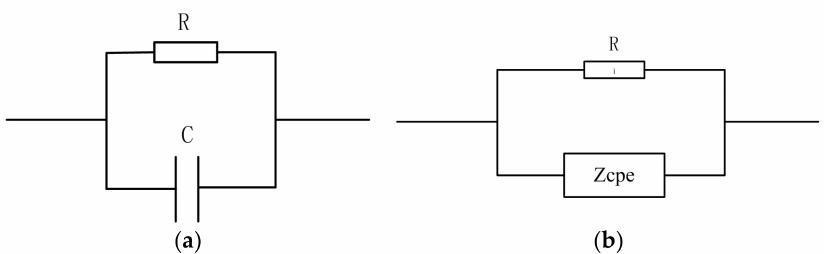
Figure 3. Two simple impedance models: ( a ) represents the initial RC skin impedance model; ( b ) represents the improved model based on ( a ) and considers the biological characteristics of the skin; the capacitance element was replaced by the constant phase angle